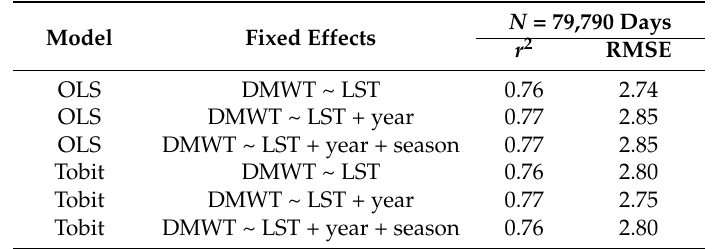
Table 2. RMSEs (in °C) and r 2 from OLS and Tobit models built using all data for the JDR across years. Models using LST only and LST + year and seasonal terms are included.